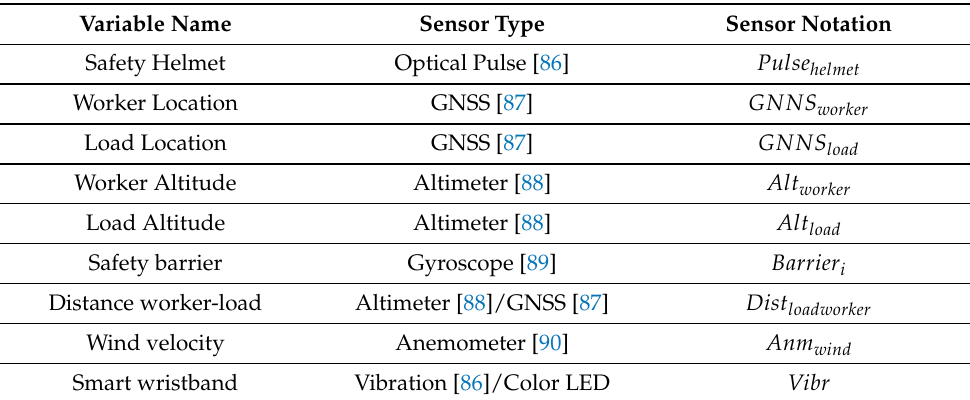
Table 2. Variables and sensors for the